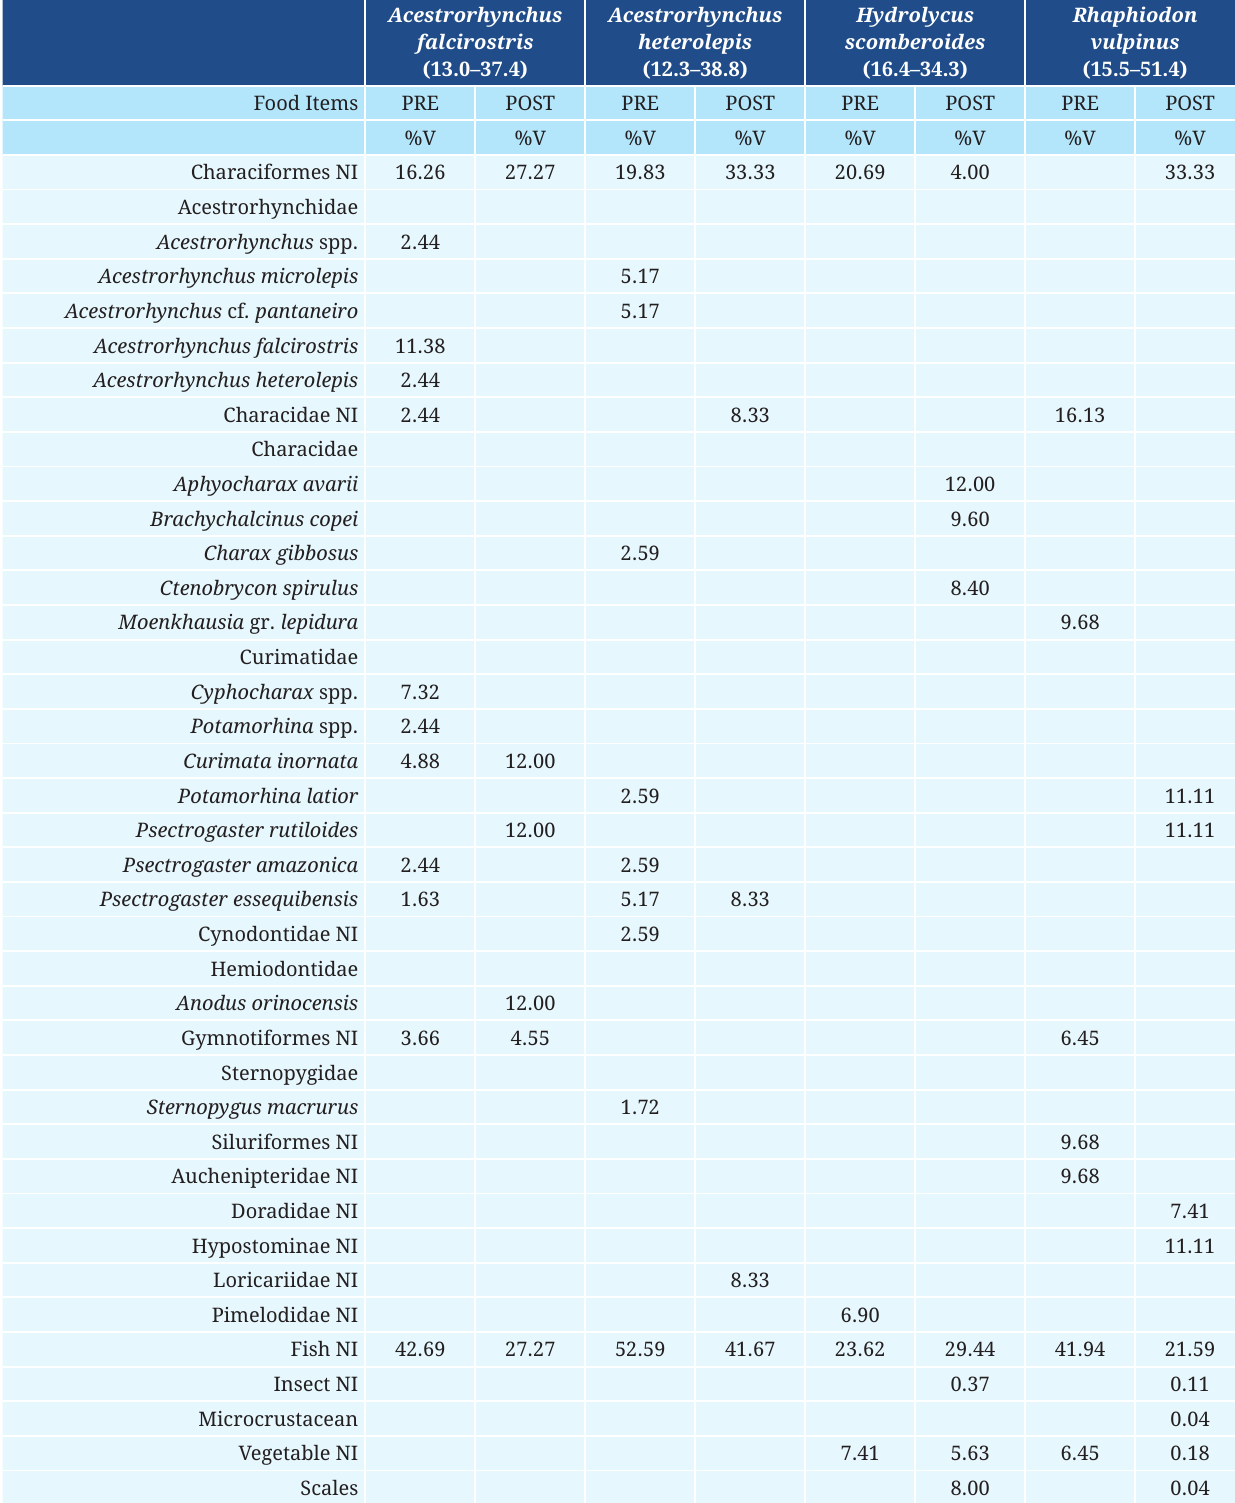
TABLE 2 | List of consumed prey by Acestrorhynchus falcirostris , A. heterolepis , Hydrolycus scomberoides , and Rhaphiodon vulpinus . V% = Volume percentual, PRE = pre-HPP (before damming) and POST = post-HPP (after damming); NI = not identified. Numbers below species name are the range of species body size in standard length measured in centimeters (values based on specimens with stomach